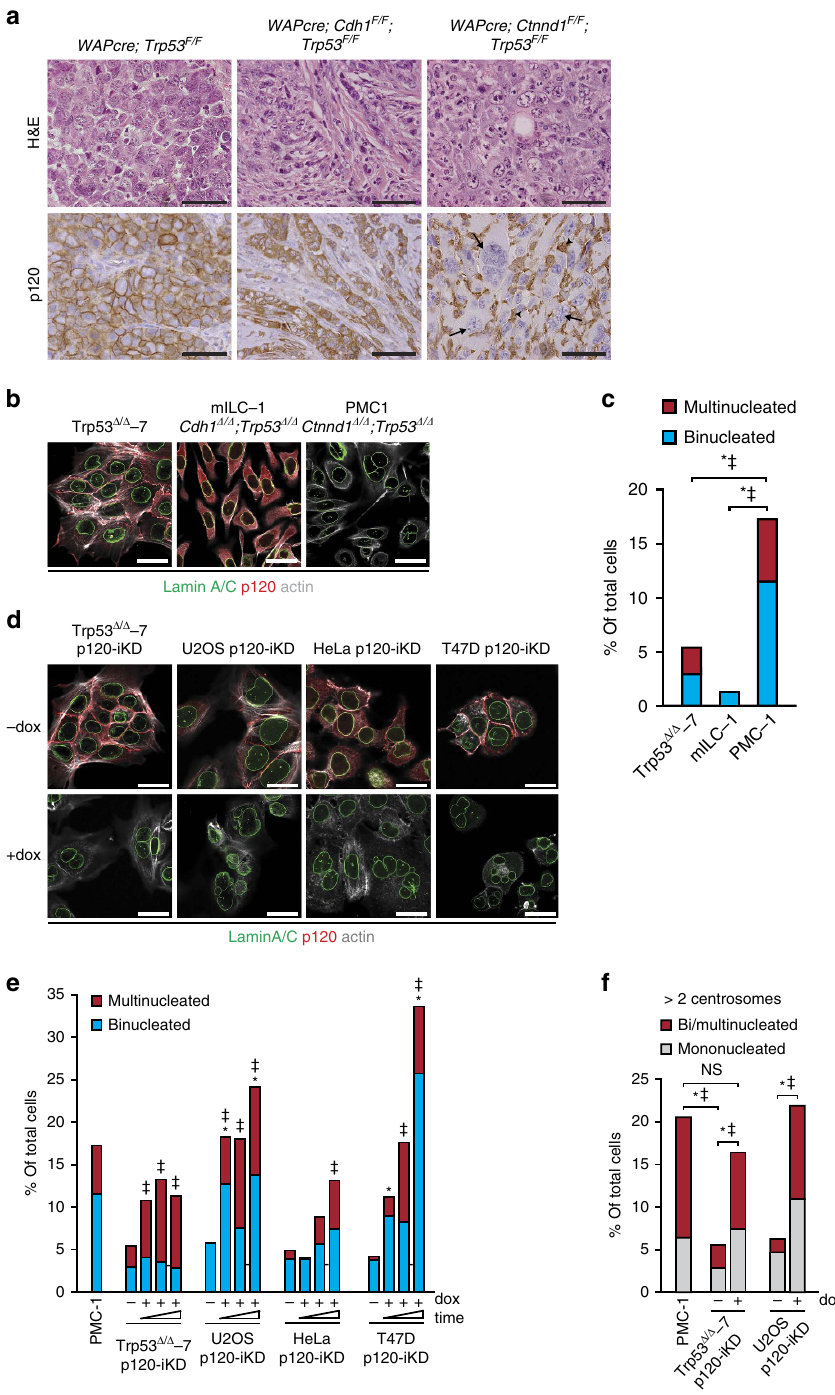
Figure 1 | Loss of p120 induces multinucleation and chromosomal instability. ( a ) Mammary-specific conditional female mice mutant for p120 and p53 ( WAPcre;Ctnnd1 F/F ;Trp53 F/F ), E-cadherin and p53 ( WAPcre;Cdh1 F/F ;Trp53 F/F ) or p53 alone ( WAPcre;Trp53 F/F ) were stained for p120. Note the overt multinucleation in the p120 knockout mammary carcinoma cells (arrow) and the prominent influx of p120 expressing immune cells (macrophages; arrow head). Tissue architecture and nuclear morphology were visualized by H&E stainings. Scale bar, 50 m m. ( b ) Immunofluorescence (IF) imaging of cell lines (Trp53 D / D -7, mILC-1 and PMC-1) derived from the corresponding tumours shown in a . Scale bar, 10 m m. ( c ) Quantification of bi- and multinucleation in the cell lines shown in b . Statistical significance was determined using the w 2 -test. * P o 0.05/ z P o 0.05 (binucleation and multinucleation, respectively). ( d ) Control (-dox) and dox-treated ( þ dox) mouse and human cancer cell lines transduced with an inducible p120KD were stained for p120 and Lamin A/ C. Scale bar, 10 m m. ( e ) Quantification of bi- and multinucleation of the p120-iKD cell lines shown in d over three consecutive passages in the absence or presence of dox. At least 200 control and dox-treated cells were analysed every passage. ( f ) Quantification of centrosome numbers in interphase PMC-1, Trp53 D / D -7 p120-iKD and U2OS p120-iKD cells. Centrosome numbers were determined by IF staining for g -tubulin. Statistical significance in c , e and f was determined using the w 2 -test. * P o 0.05/ z P o 0.05 (binucleation and multinucleation respectively). NS, not